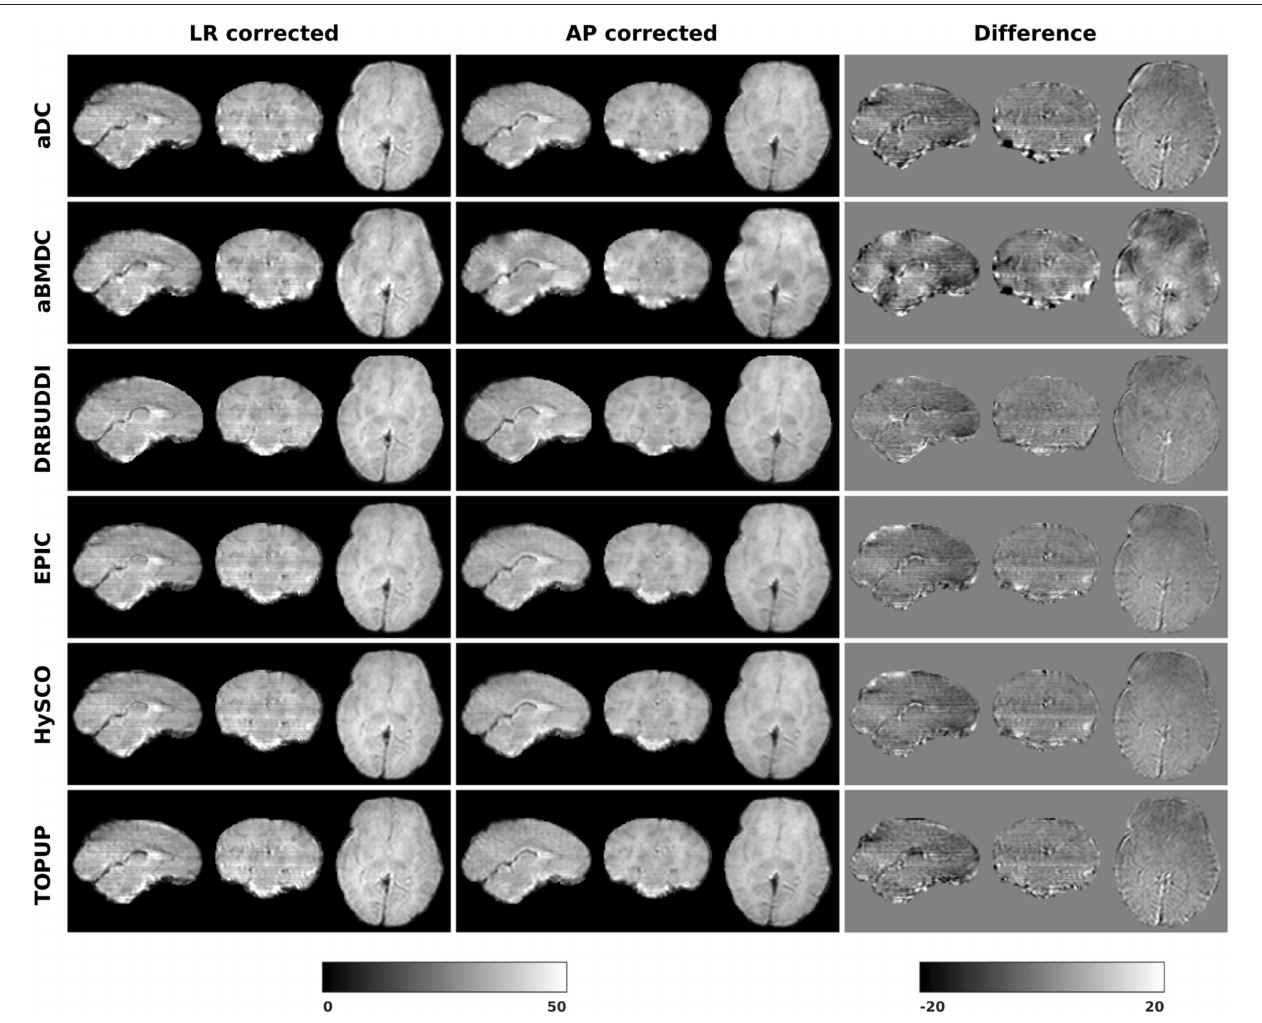
FIGURE 15 | Difference between corrected b 0 volumes from LR and AP for dHCP Subject CC00069XX12 using the six methods.